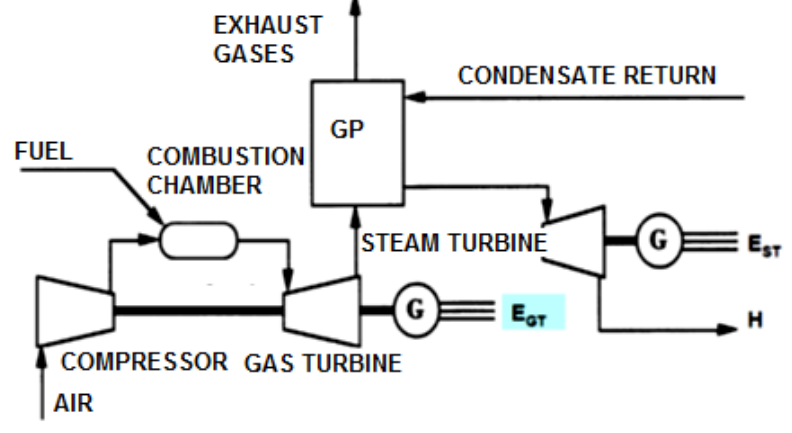
Fig. 3. Combined gas – steam cycle: